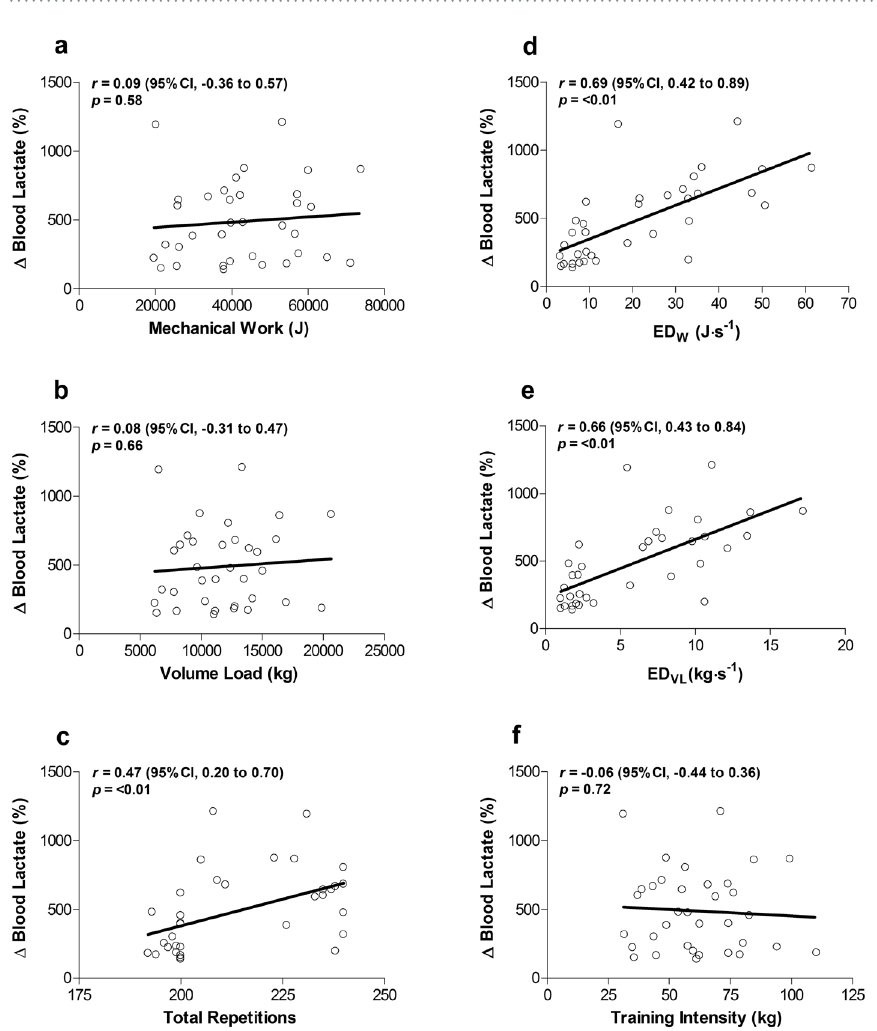
Figure 3. Pearson correlations between relative change in blood lactate concentration following resistance exercise and ( a ) mechanical work, ( b ) Volume Load, ( c ) Total Repetitions, ( d ) ED W , ( e ) ED VL and ( f ) TI. * Correlation is significant at p <